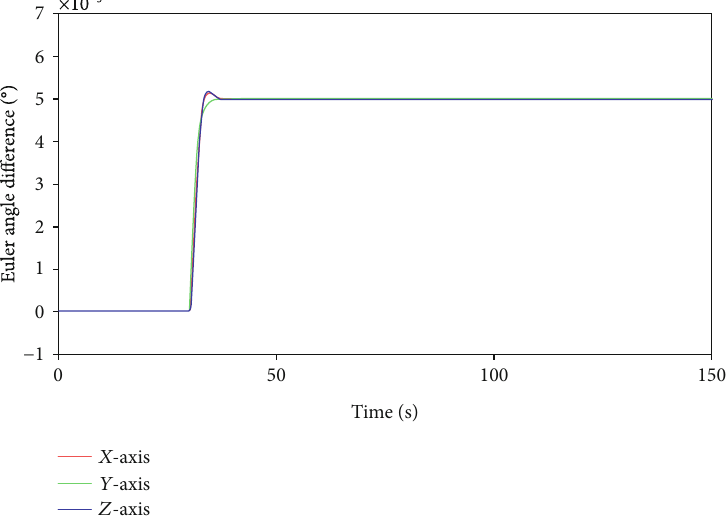
Figure 12: Step response of the neural network controller when the satellite stares at the central ground